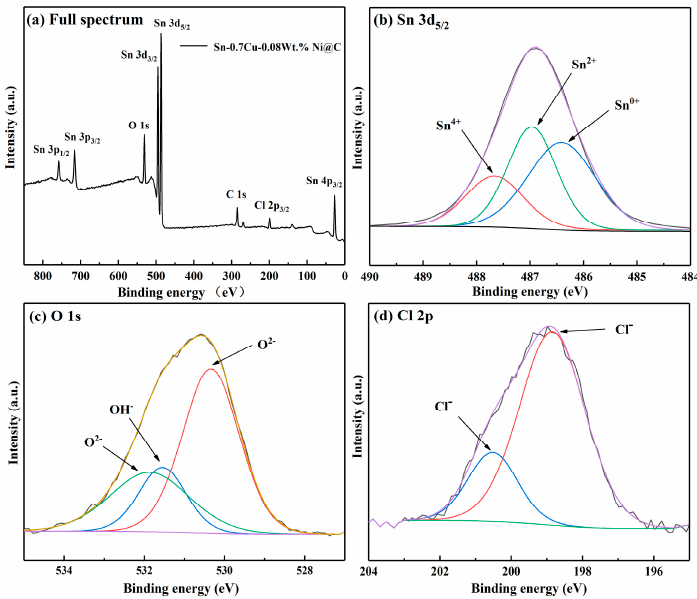
Figure 4. XPS images of Sn-0.7Cu-0.08 wt.% Ni@C after electrochemical corrosion: ( a ) full spectrum, ( b ) Sn 3d 5/2 , ( c ) O 1s, ( d ) Cl 2p.